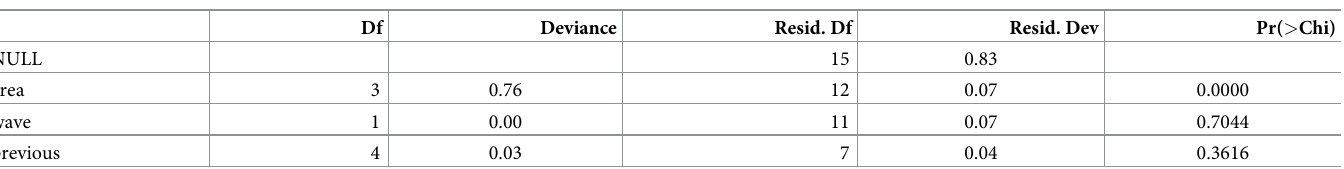
Table 12. ANOVA results for noise.